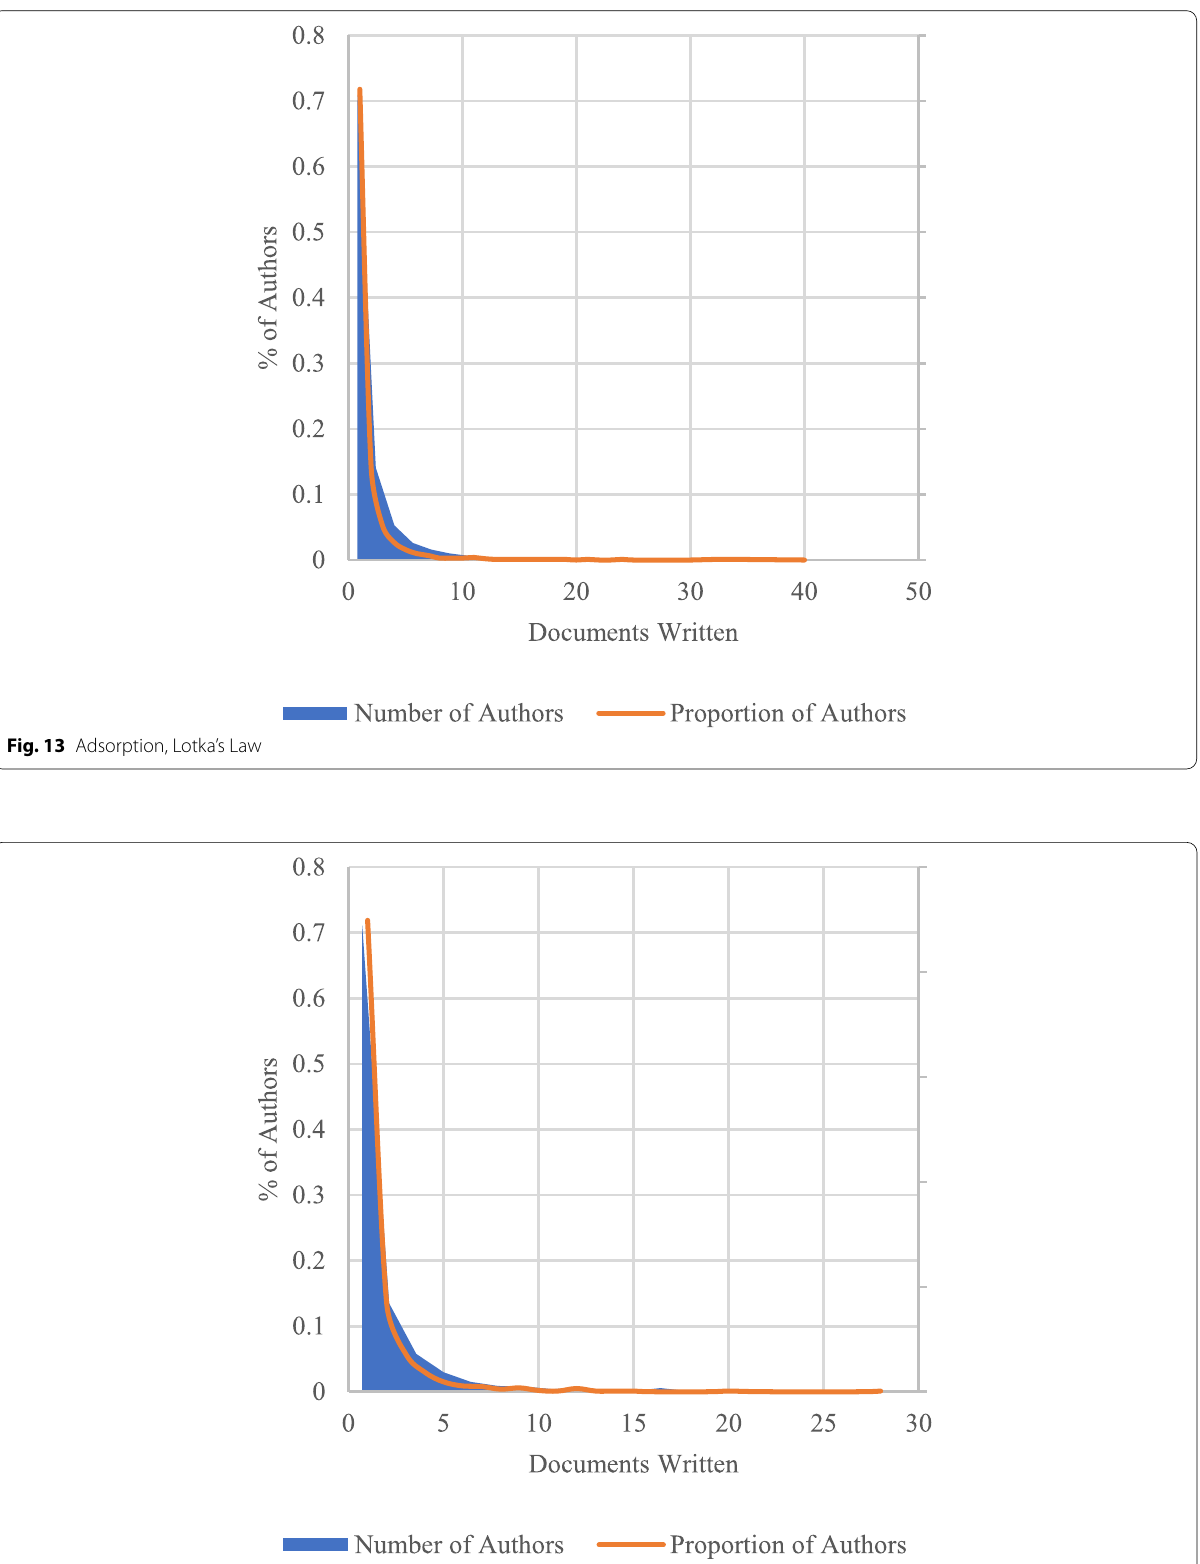
Fig. 14 Absorption, Lotkas